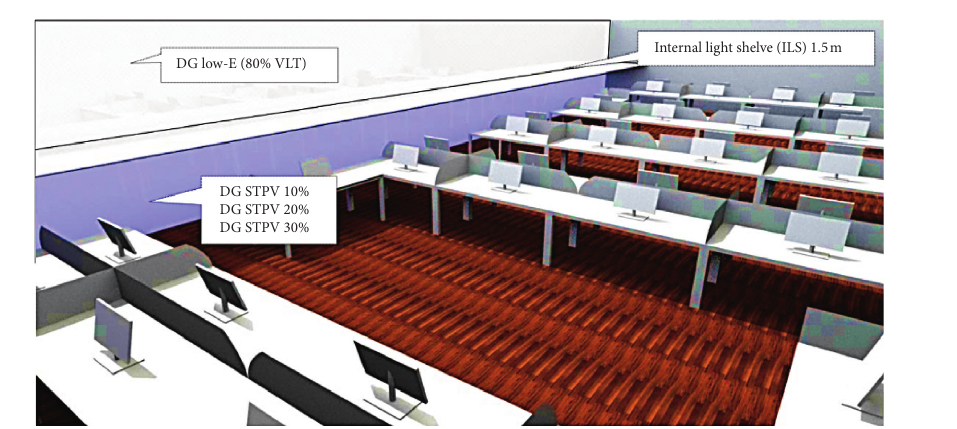
Figure 3: Optimum STPV and ILS